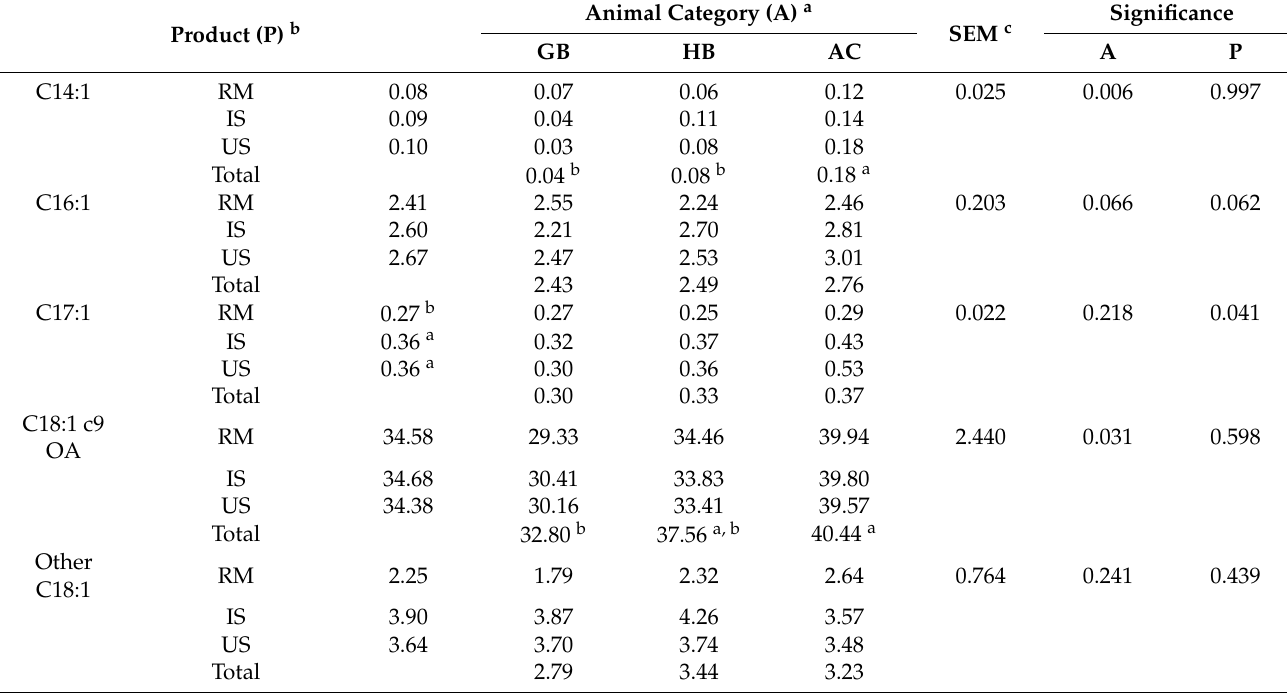
The results indicate mean values of three measurements performed on each trial of each carcass. a Animal category: GB = grazing young bull; HB = housed young bull; AC = adult cow. b Product: RM= raw mixture (day 0), IS= inoculated salami (day 45), US = uninoculated salami (day 45). c SEM= standard error of the means. The interactions among the effects were removed from the model because not significant ( p > 0.05). Different letters ( a,b ) on horizontal and vertical rows indicate p <